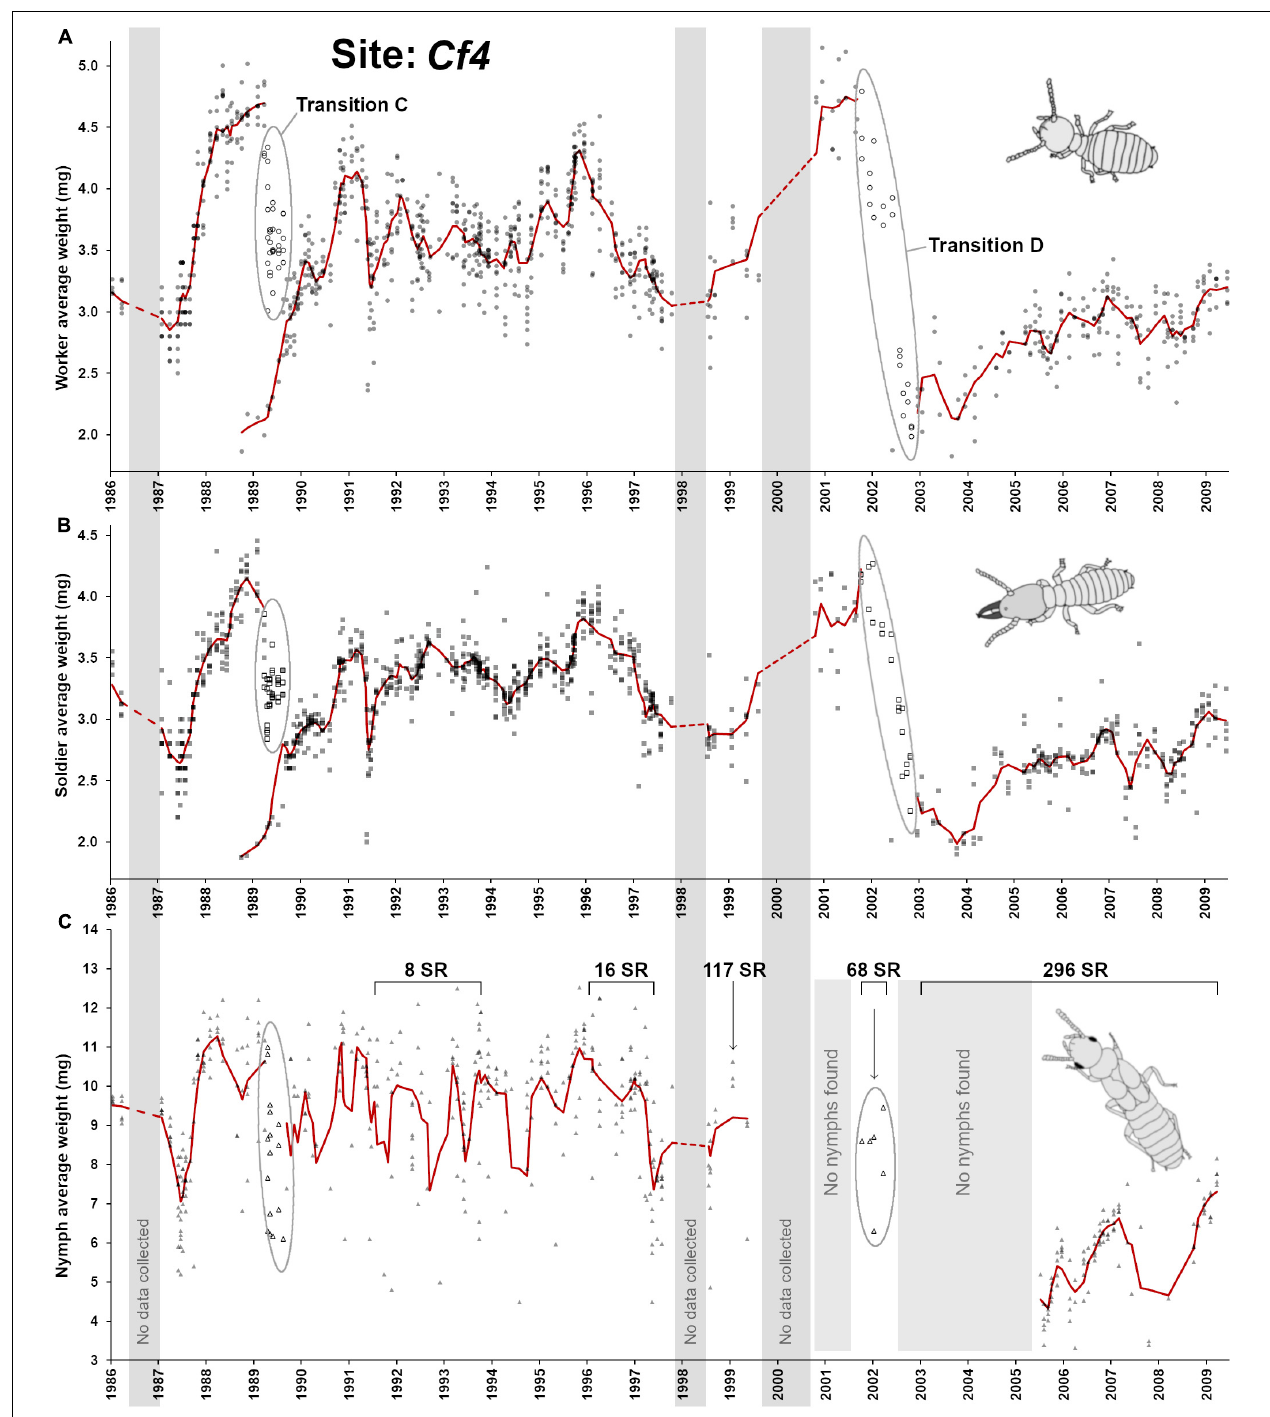
FIGURE 7 | Colony demographic changes for Coptotermes formosanus at site Cf4 . Each data point represents an average caste weight from a field trap. For the 1986–2009 demographic trends of each caste, the red line represents the rolling average function (period = 3). (A) Workers’ average weight. (B) Soldiers’ average weight. (C) Nymphs’ average weight. “Transition C” represents colony senescence and simultaneous colony fusion with a young neighboring colony. “Transition D” represents a generational demographic turnover followed by putative cycles of inbreeding associated with secondary reproductives = SR), and a temporary absence of nymph production prior to colony “re-maturation”